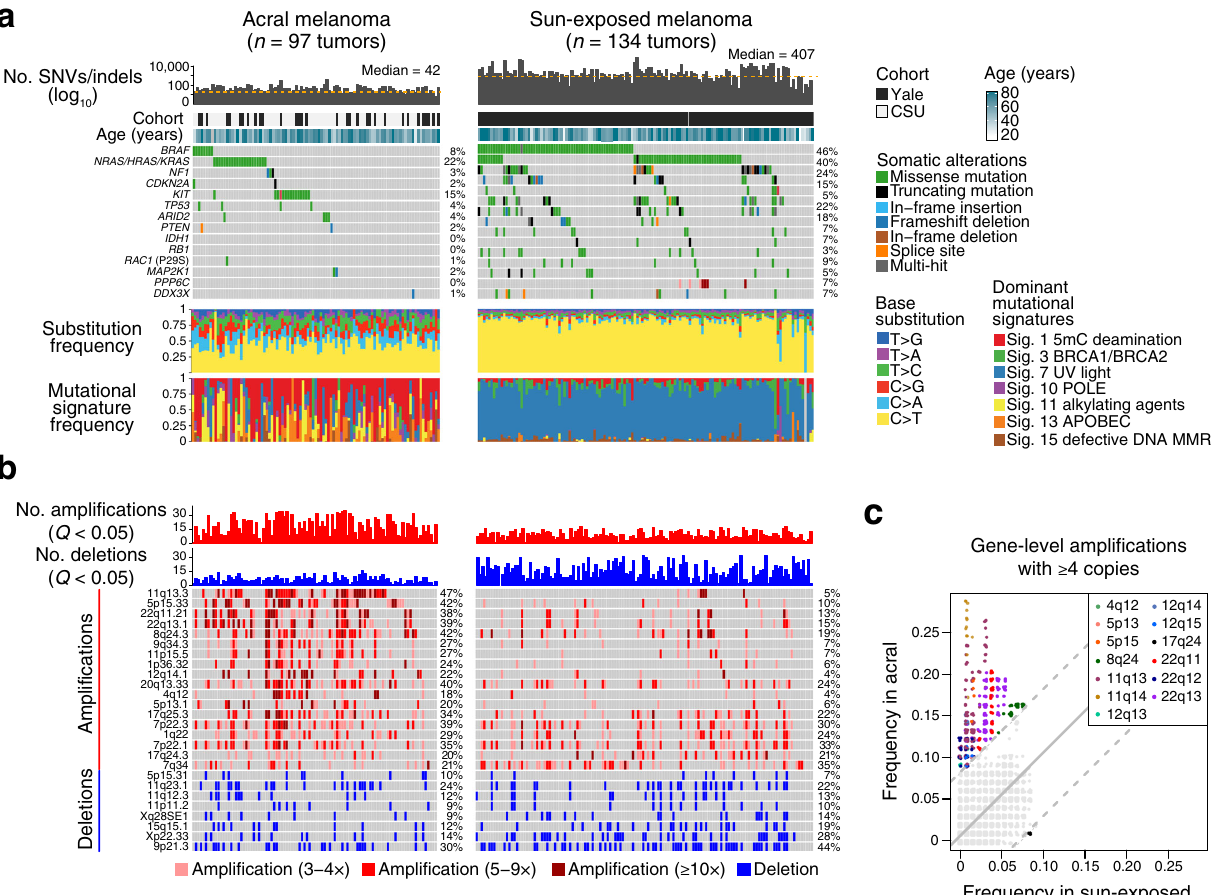
Fig. 1 Landscape of somatic alterations in acral and sun-exposed melanomas. a , b Genomic and clinical characterization of acral and sun-exposed melanoma samples sequenced in this work. a The number of nonsynonymous SNVs and indels per melanoma exome (columns), cohort, age, frequently mutated genes in either subtype (Methods), nonsynonymous base substitution frequencies, and dominant COSMIC mutational signatures 122, 123 . Sig. signature, 5mC 5-methylcytosine. See also Supplementary Data 2b, c for the results of mutational signi fi cance analysis with MutSigCV 102 . b The number of signi fi cant focal ampli fi cations and deletions (GISTIC Q < 0.05) per melanoma exome (columns), ordered identically to panel a . Cytobands with focal ampli fi cations or deletions with at least 10% recurrence frequency in either melanoma subtype are shown (GISTIC Q < 10 – 5 ), ordered by the relative difference in recurrence frequency in acral versus sun-exposed melanoma. c Genes are plotted according to the fraction of acral ( y -axis) or sun-exposed ( x - axis) tumors where they are present with ≥ 4 copies. Considering the genome-wide distribution of differences in recurrence frequencies between melanoma subtypes, genes are identi fi ed as signi fi cantly recurrent in acral or sun-exposed melanomas if their | z -score| ≥ 3 (dashed lines). Signi fi cantly recurrent genes are colored according to their cytoband location (inset). For clarity, a small amount of jitter was added to distinguish overlapping genes. Source data are provided as a Source Data